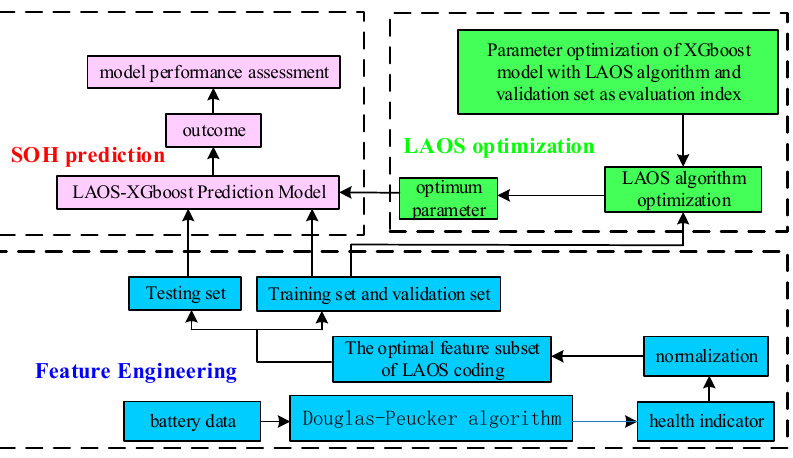
Figure 3. IDP-based lithium battery health factor extraction and SOH prediction model. The lithium battery health factor extraction and SOH prediction model based on IDP mainly comprise feature engineering, LAOS optimization, and SOH prediction. The data feature engineering part mainly uses the IDP algorithm to extract the health factor of each cycle data of the battery and cascades the binary LAOS encoder for feature selection. The LAOS optimization part uses the LAOS algorithm to optimize the hyper-parameters of the XGboost model and obtain the optimal parameters. The SOH prediction part is to train and test the XGboost model to predict the SOH of the battery and evaluate the